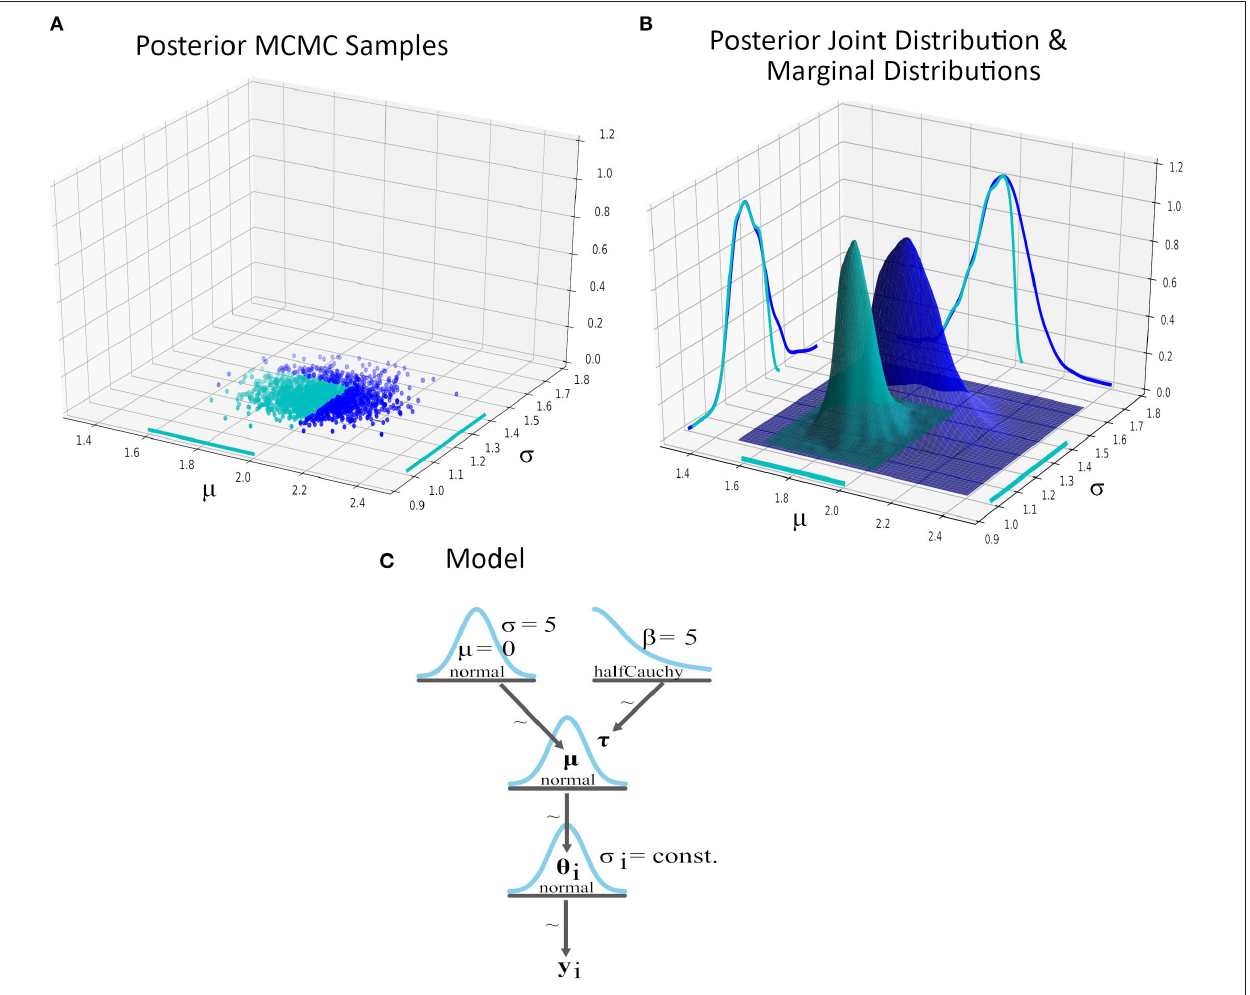
FIGURE 1 | A two-parameter Bayesian model modeling the average minimum temperature in Scotland for the month November. The data provides the average minimum temperature in Scotland in month November for the years 1884–2020 and PyMC3 was used for the inference (see Supplementary Material for details). We explore the inference by setting two value range restrictions; µ ∈ [1.6,2.0] and σ ∈ [1.0,1.4]. (A) Posterior MCMC samples of the model’s parameters. The samples that lie within the intersection of the value range restrictions are colored in cyan. (B) The estimated posterior distributions and marginal distributions based on the entire posterior MCMC sample set (dark blue) and the restricted sample set (cyan). (C) A DAG representation of the two-parameter Bayesian model as a Kruschke-style diagram ( Kruschke, 2015). The posterior marginal distribution of µ (in cyan) in the subset of the posterior space became slightly tighter and shifted toward lower values of µ , which lead us to less uncertainty about expecting lower average temperature in Scotland for November given this particular